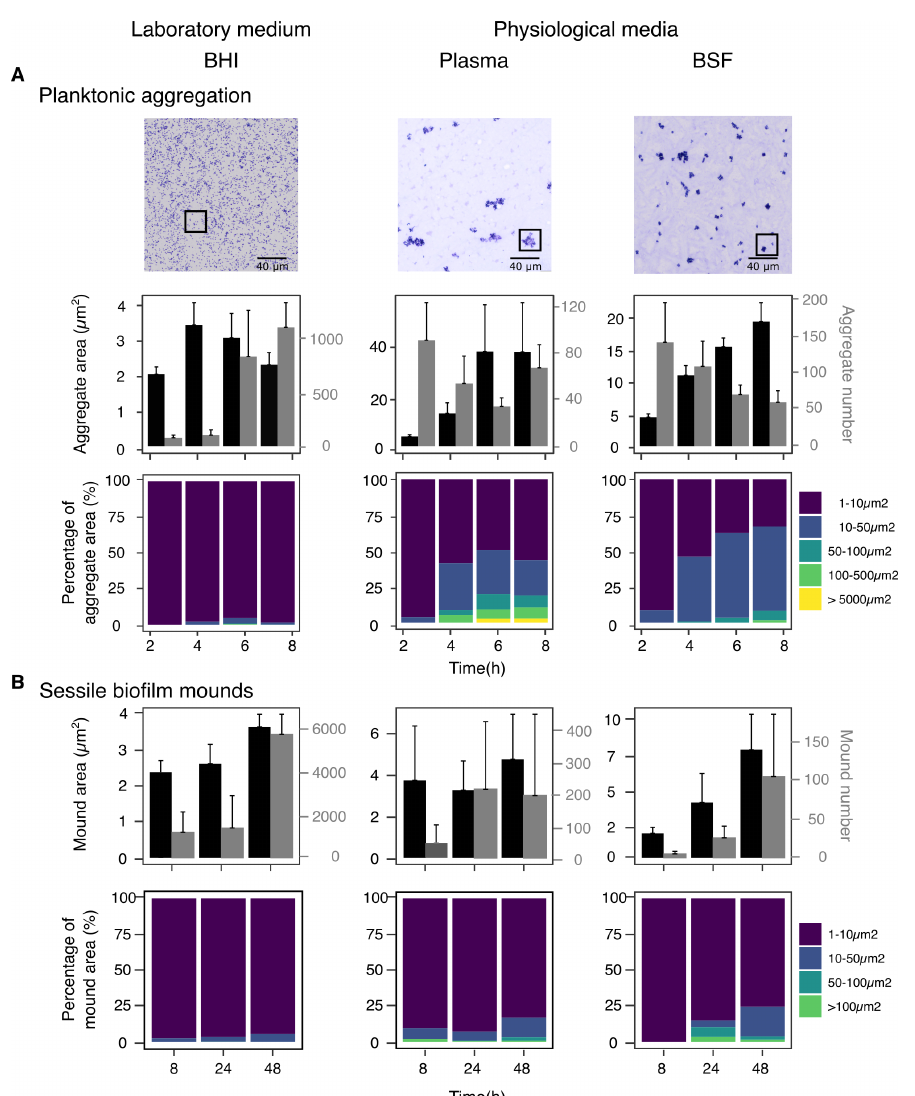
Figure 5. Kinetics of planktonic aggregation and sessile biofilm formation is highly sensitive to changes in growth medium. ( A ) Kinetic of planktonic aggregation in different media. Top panel: micrography of precipitated planktonic aggregates in different media. See Figure S7 for a zoomed-in version of the image portions in the black squares, together with exemplative aggregate size measures. Mid panel: mean and standard deviation of aggregate size (black); mean and standard deviation of aggregate number (gray). Bottom panel: kinetic of percentage abundance of aggregates of different sizes. ( B ) Kinetic of sessile biofilm formation in different media. Top panel: mean and standard deviation of biofilm mound size (black); mean and standard deviation of biofilm mound number (gray). Bottom panel: kinetic of percentage abundance of biofilm mounds of different